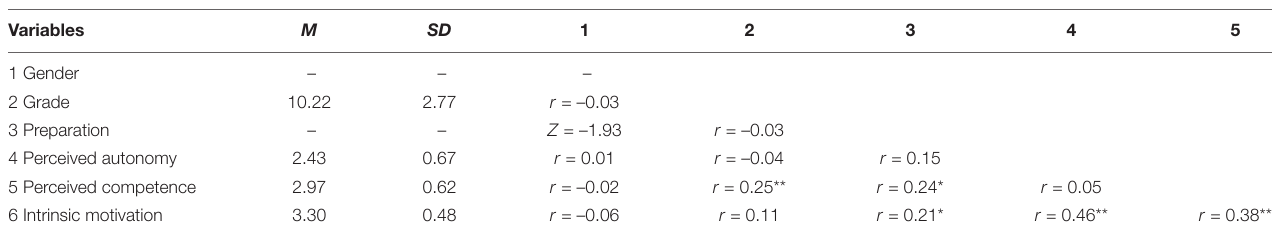
TABLE 1 | Descriptive statistics of and correlations between all investigated variables.